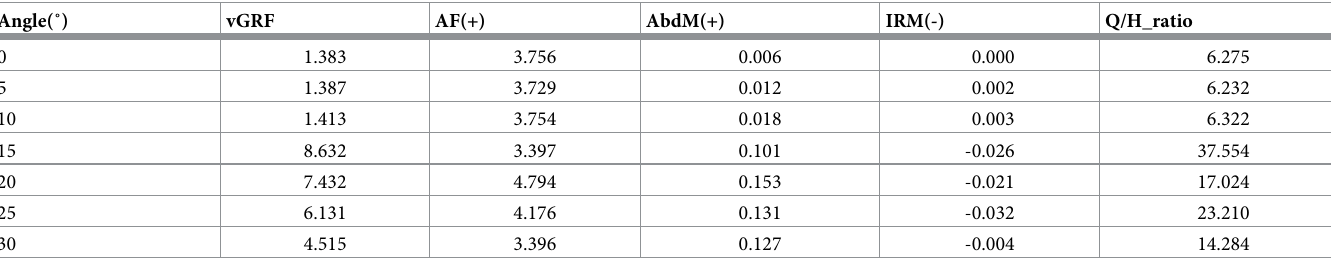
Table 7. Vertical GRF, knee JRF and JRM and Q/H force ratio at peak vGRF time instance for multiple trunk right bending angles.